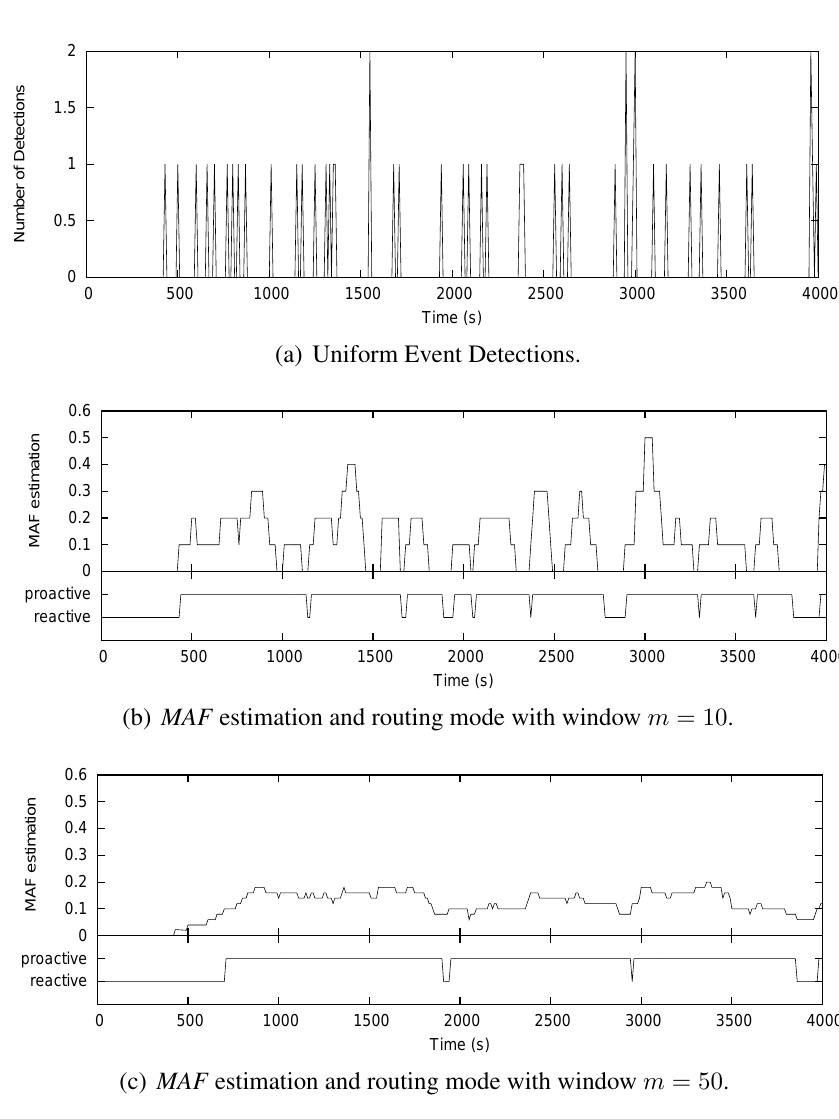
Figure 7. Multi-MAF’s adaptive model (uniform event